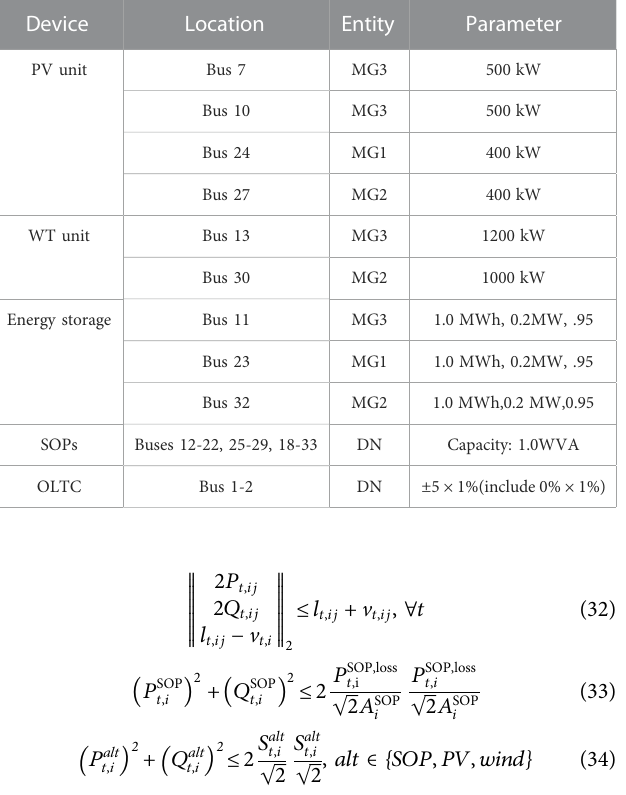
TABLE 2 Relevant parameters of IEEE 33 bus test system. Device